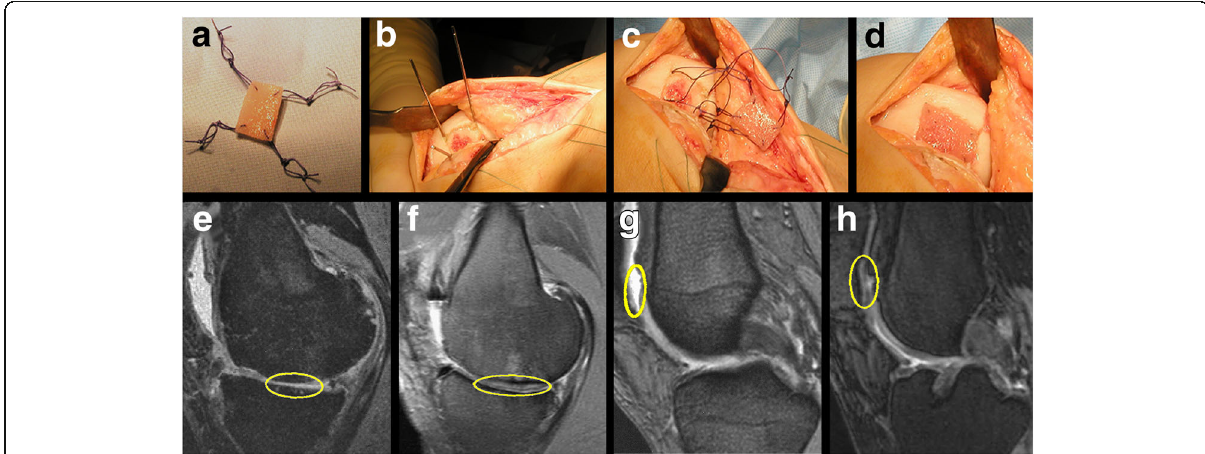
Fig. 2 For implantation, BioSeed-C was armed from the corners with resorbable sutures secured by threefold knots ( a ), k-wires were drilled in the corner of the defect ( b ), using the k-wires, the guiding threads were pulled through the femoral bone, and the knots were guided into the subchondral bone ( c ), the knots functioned as anchors, seized the subchondral bone and fixed the implant ( d ), MRI showing the cartilage defect at the medial femoral condyle before implantation ( e ) and after four years where the defect was completely filled ( f ), and the MRI shows a patellar cartilage defect before implantation ( g ) and after four years where defect was completely filled ( h ). Adapted with a minor modification from (Kreuz et al.